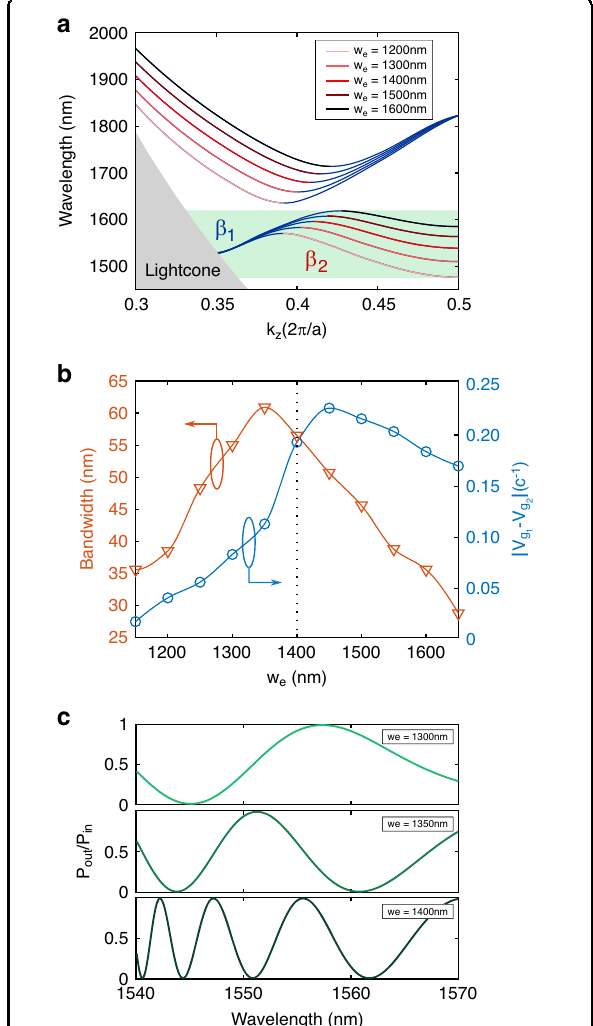
Fig. 2 Optimization of the band structure. a Second and third bands for different transversal element lengths w e (the rest of the design parameters are the same as previously detailed). The contributions of the fundamental and higher-order modes to band formation in the bimodal region are depicted in blue and red, respectively. b Trade-off between the group velocity difference between both modes (in blue) and the bimodal bandwidth (in orange) as a function of w e . The group velocity difference was calculated for those wavelengths in the lower edge of the bimodal ROI where a slow light behaviour is obtained for the higher order. c Ratio between the output and input power, calculated as the squared cosine of the phase shift as a function of the wavelength. Various w e lengths are considered, representing the interference pattern evolution as a result of the slow light